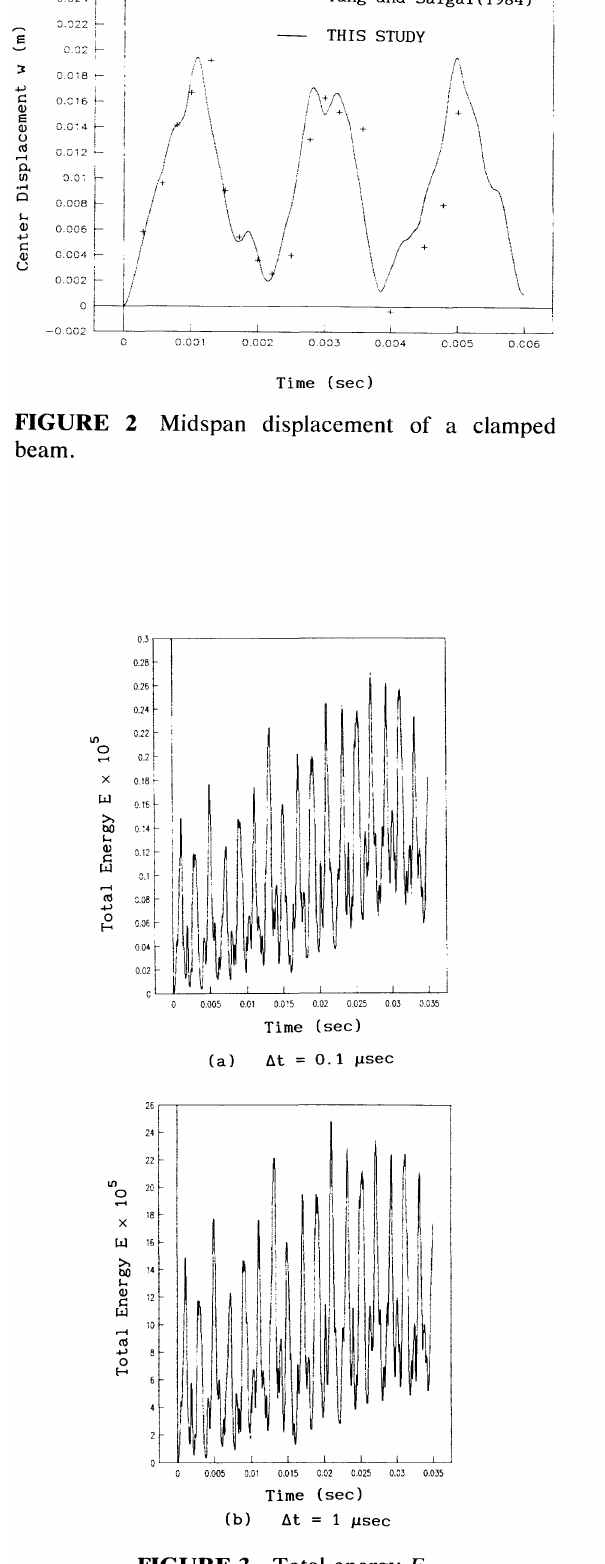
FIGURE 3 Total energy E.